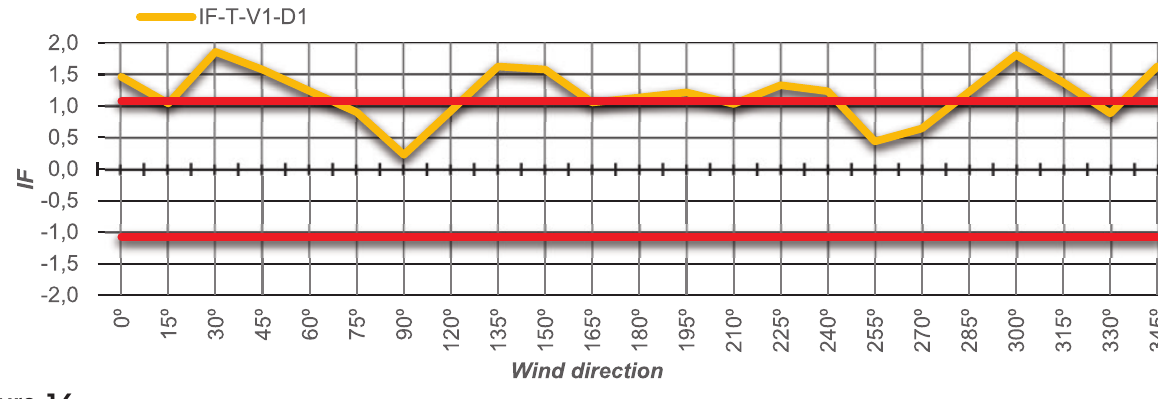
Interference Factor (IF) Analyses of torsion of vicinity V1 positioned at distance D1